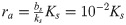
Plot of activated regulator concentration, ra = r4, at the center of the colony as a function of geometric size measure, Σ.Both axes are in natural units. The exact solution depicts the solution found when solving Eqs (2)–(5) and (8), whereas non-buffered solution uses Eq (6). The quasi-static solution uses Eqs (6) and (9). The ignition point, ra=bsksKs=10-2Ks, is indicated, as well as the dissociation constant Ks and maximum regulator concentration rm. The exact solution is displayed with circles corresponding to 10 second intervals to indicate the speed of the ignition.